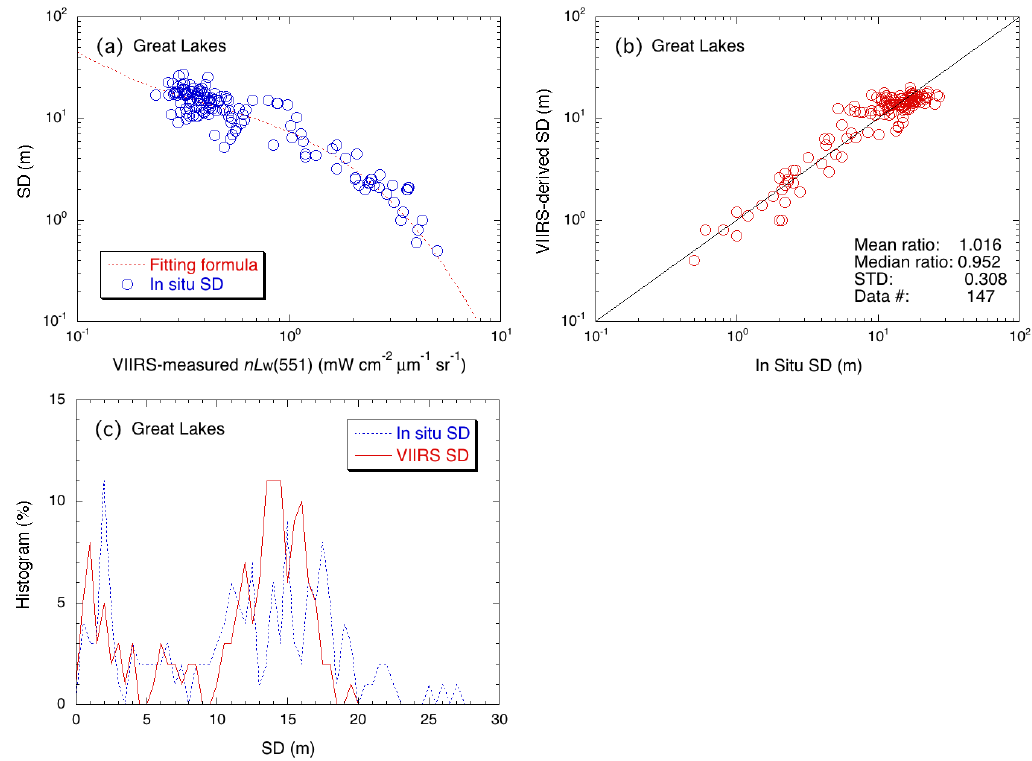
Figure 5. ( a ) In-situ-measured SD as a function of VIIRS-SNPP-derived nL w (551) for the Great Lakes, ( b ) match-up comparison of VIIRS-SNPP-derived SD using the new algorithm (Equation (3)) with the in-situ SD data, and ( c ) histogram results of VIIRS-SNPP-derived (red solid line) and in-situ SD (blue dotted line) data.